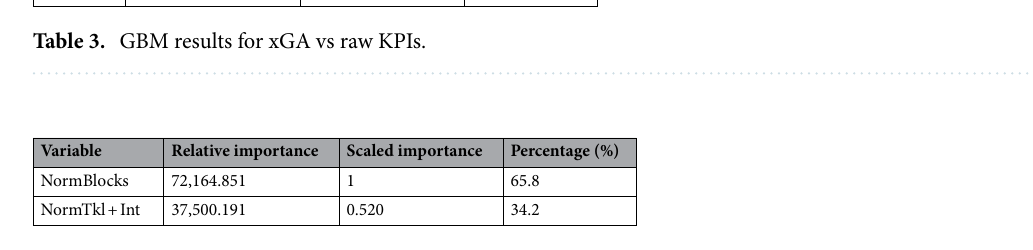
Table 4. GBM results for xGA vs normalized